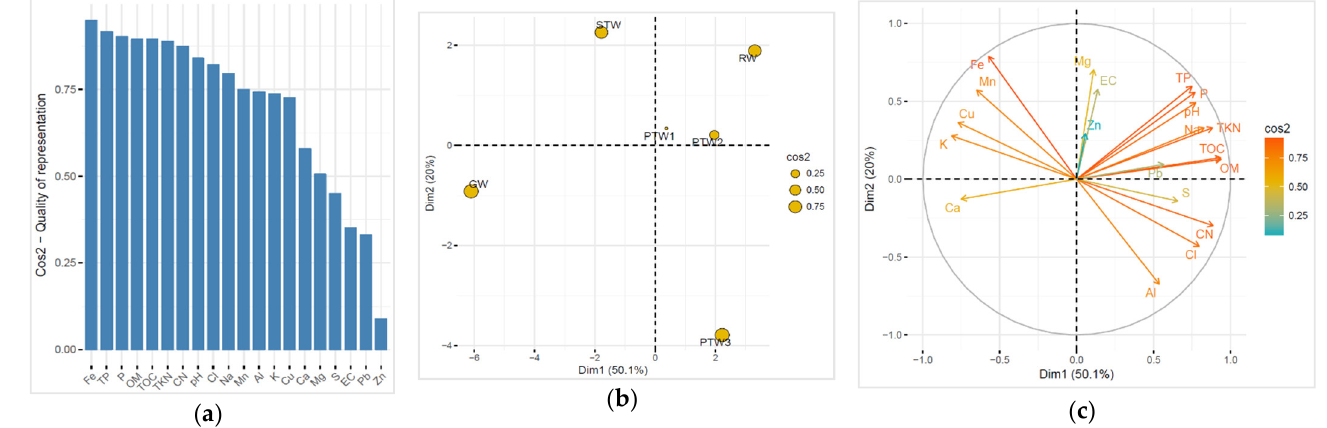
Figure 3. Scatter plot based on principal component analysis (PCA): ( a ) Cos 2 of variables’ contribution; ( b ) PCA of treated wastewater from both systems; ( c ) PCA analysis using all using all the measured soil parameters.